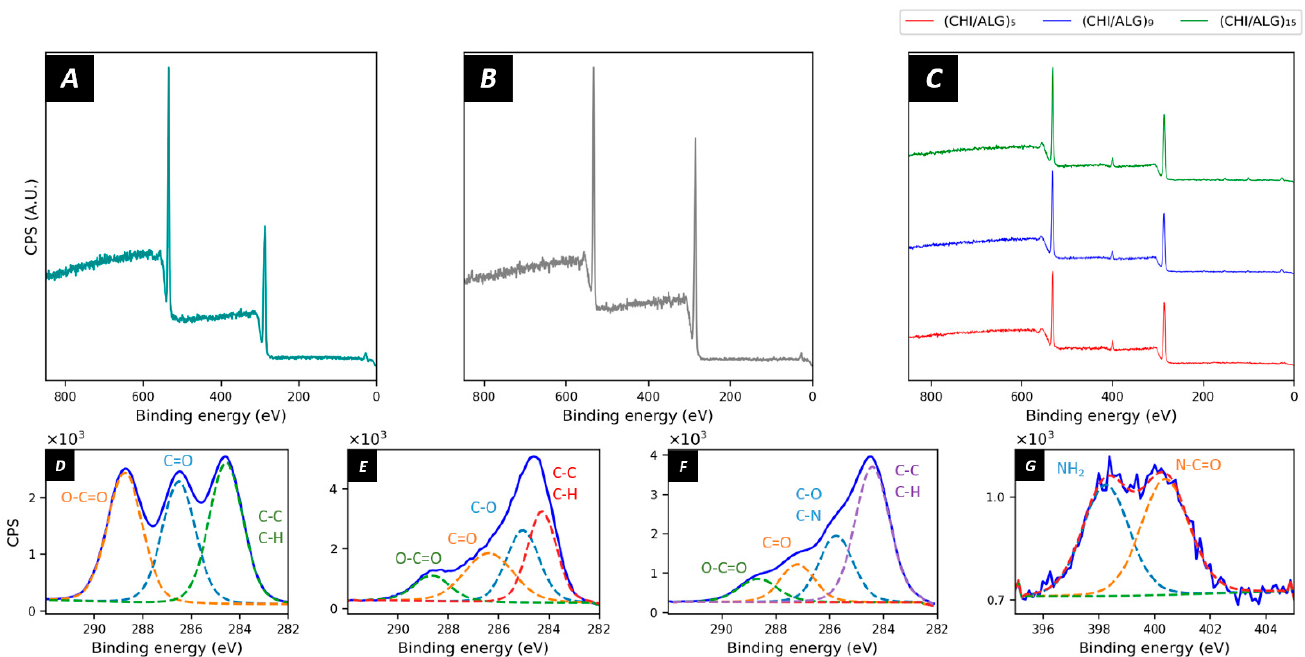
Figure 4. XPS survey scans of ( A ) PLGA, ( B ) plasma-coated PLGA, ( C ) (CHI/ALG) 5 , (CHI/ALG) 9 , and (CHI/ALG) 15 . The latter demonstrates a succesful deposition of chitosan due to the apparition of the typical peaks at 396–404 eV, depicting the presence of nitrogen onto the surface of the meshes. The region scans for ( D ) C1s of PLGA, ( E ) C1s of plasma-coated PLGA, and ( F ) C(1s) of (CHI/ALG) 5 show the chemical changes on the surface throughout the different steps of the coating. The region scan for ( G ) N1s of (CHI/ALG) 5 was used as an example of the nitrogen peak appearing after the deposition of chitosan.